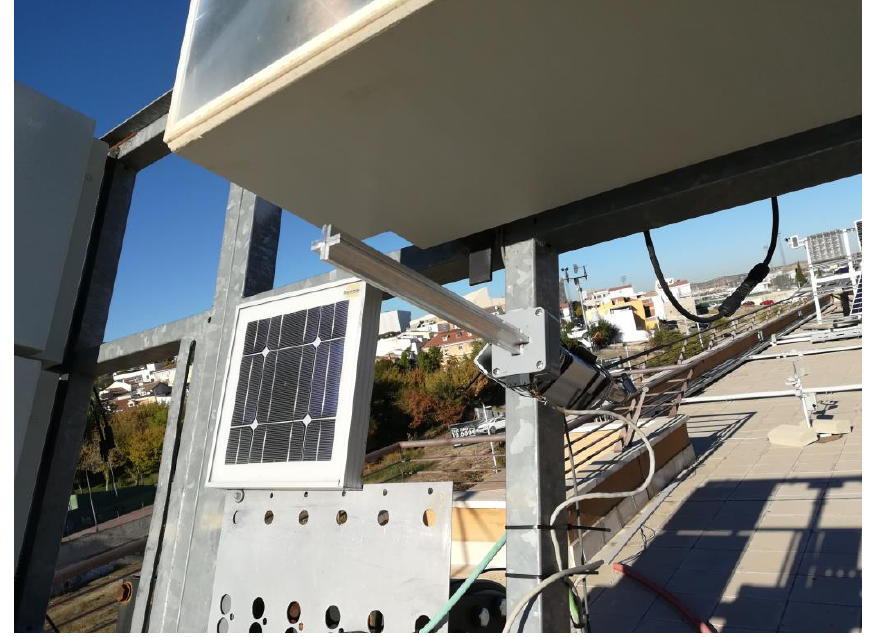
Figure 14. Pointing device.